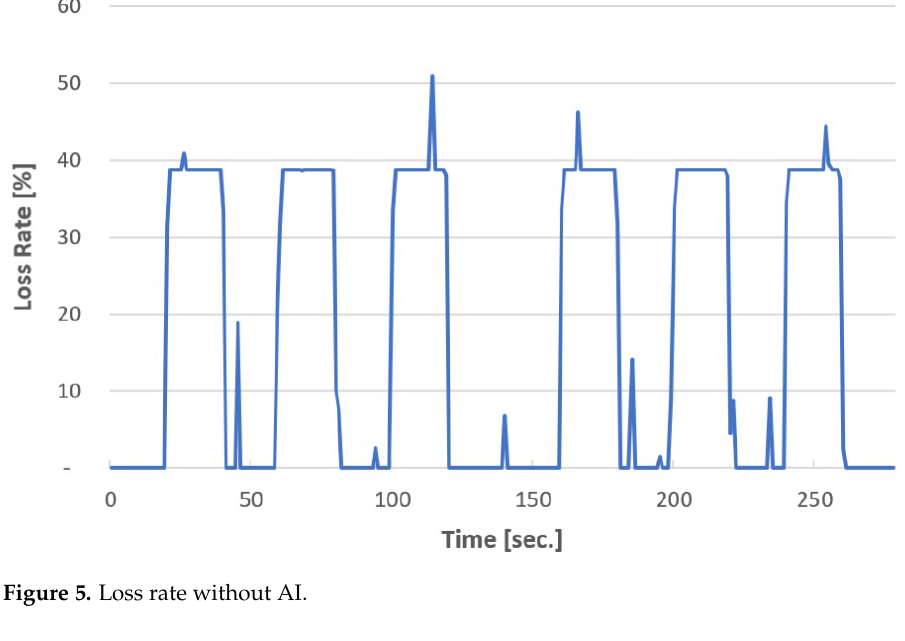
Figure 5. Loss rate without AI.